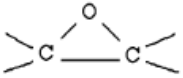
Figure 6. Three-member epoxy ring.